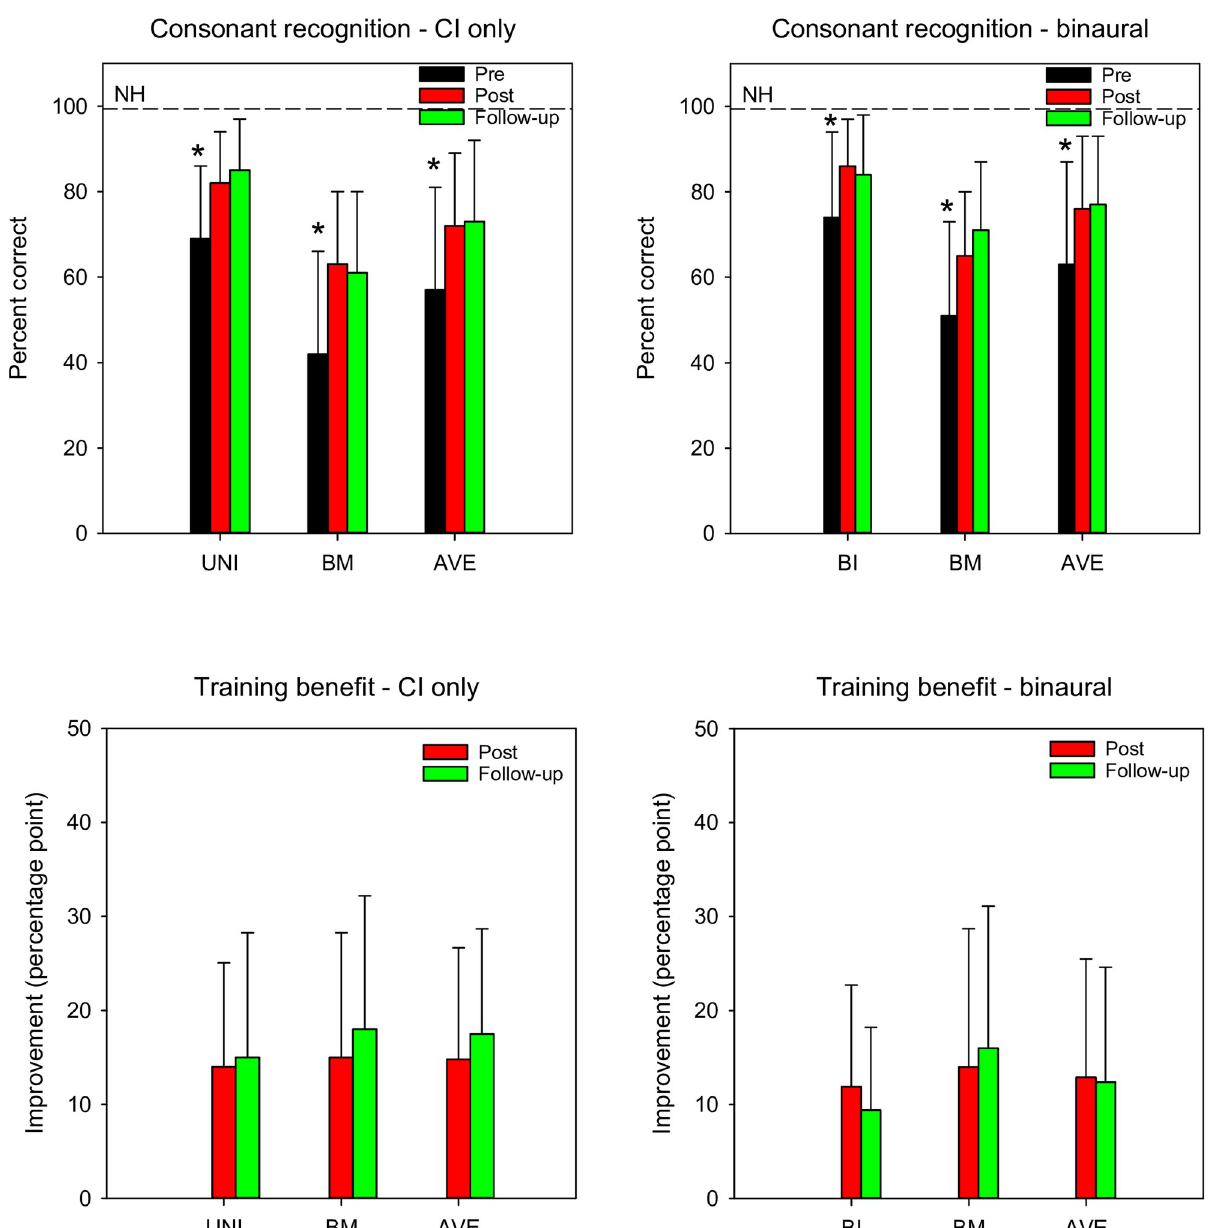
Fig 4. Mean consonant recognition and training benefit. The top panels show consonant recognition scores with CI-only (left) and binaural listening (right); the dashed lines show mean NH performance. The bottom panels show training benefit with CI-only (left) and binaural listening (right). The error bars show the standard deviation. The asterisks show significantly different